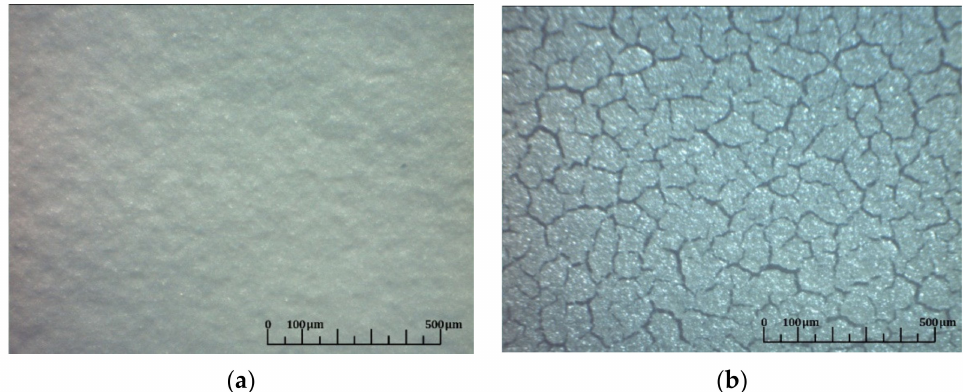
Figure 9. Optical photographs of the surface of the deposited two-layer electrolyte BCZYYbO- CuO/SDC: ( a ) after deposition and drying of the SDC layer; ( b ) and after sintering in air at a temperature of 1400 ◦ C for 5